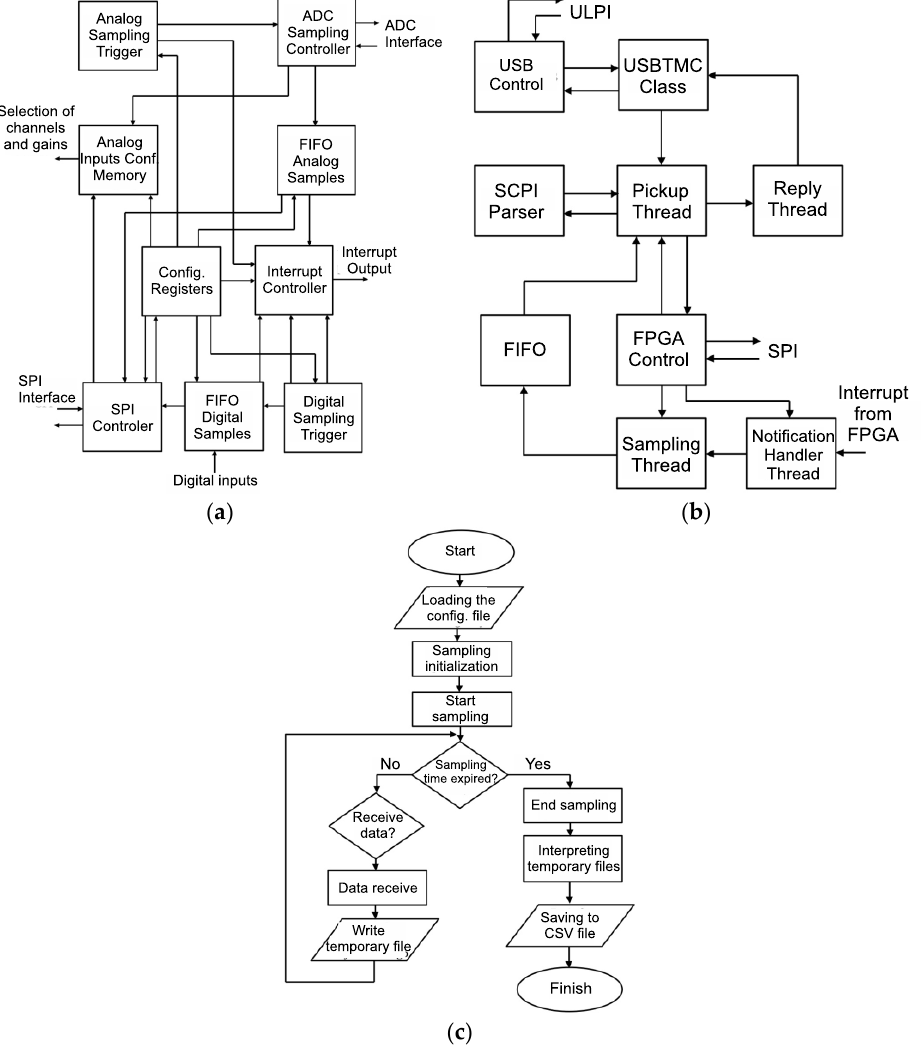
Figure 8. Simplified block diagram of FPGA software ( a ). Block diagram of the relationship between MCU software elements ( b ). Simplified program operation diagram on a computer ( c ).